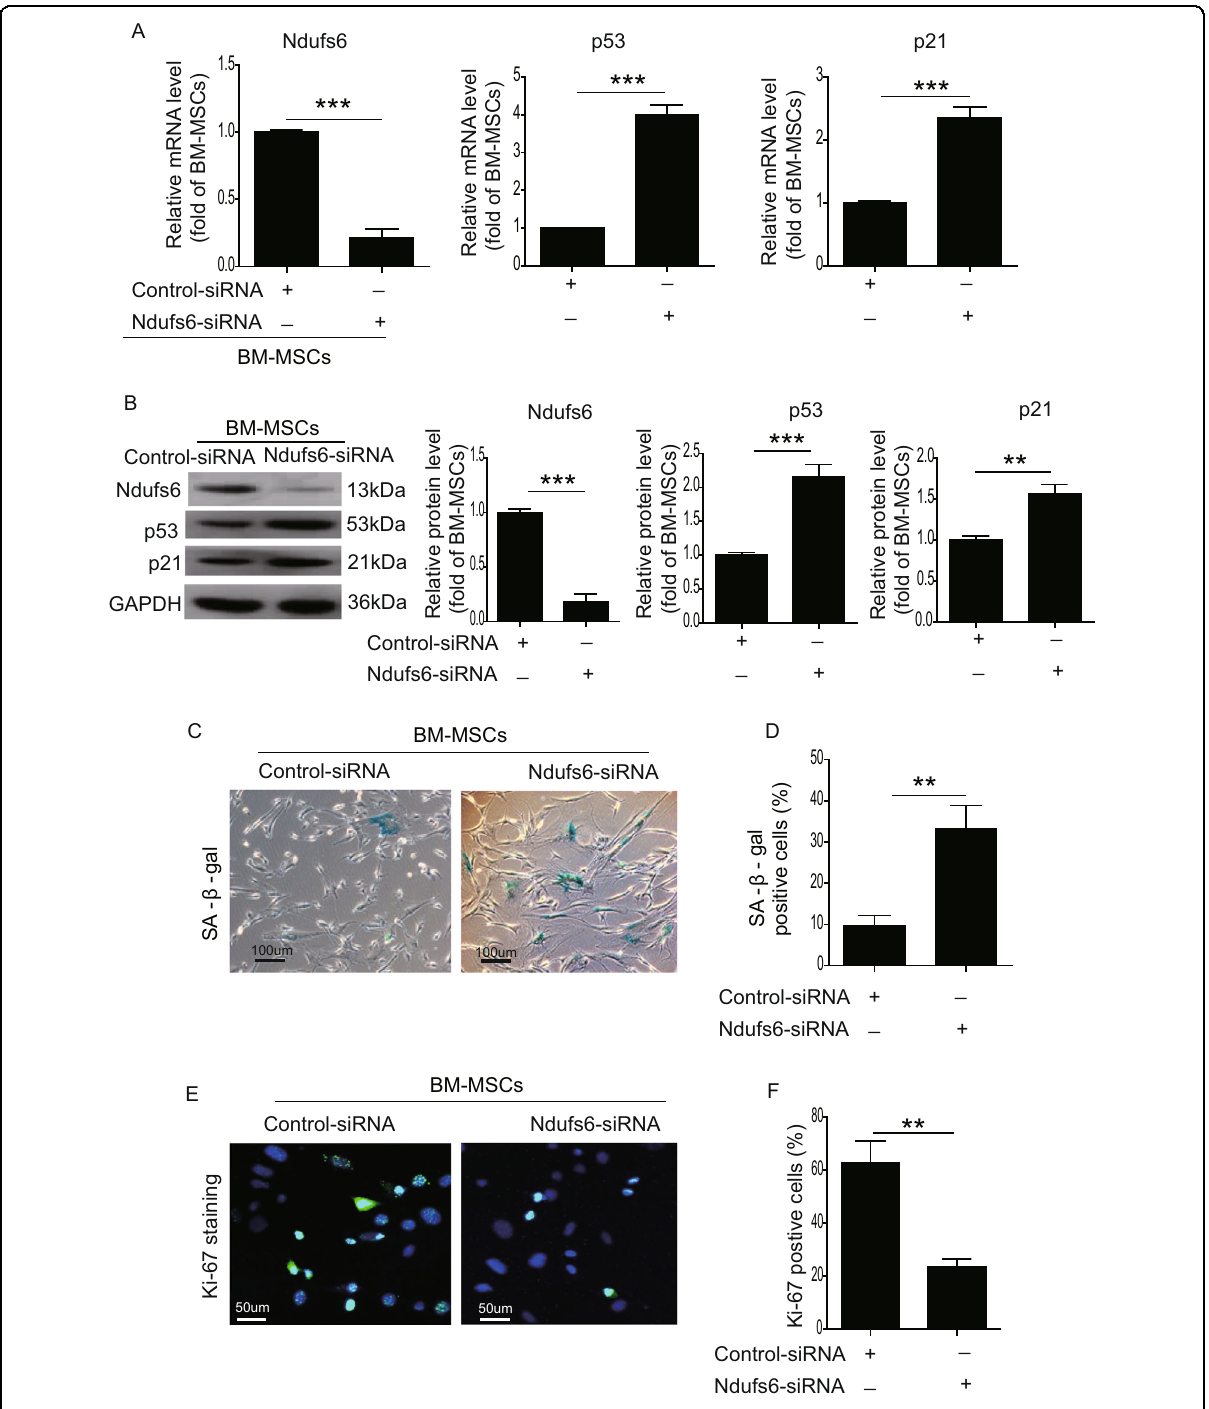
Fig. 3 Ndufs6 knockout accelerates cellular senescence in BM-MSCs. A The mRNA level of Ndufs6, p53, and p21 was detected in BM-MSCs and Ndufs6-siRNA-treated BM-MSCs. B The protein level of Ndufs6, p53, and p21 was detected in BM-MSCs and Ndufs6-siRNA-treated BM-MSCs. C SA- β -gal staining showing β -gal-positive cells in BM-MSCs and Ndufs6-siRNA-treated BM-MSCs. D The β -gal positivity in BM-MSCs and Ndufs6-siRNA- treated BM-MSCs was quanti fi ed by calculating the ratio of stained cells to total cells. E The proliferation of BM-MSCs and Ndufs6-siRNA-treated BM- MSCs was assessed by Ki-67 staining. F The Ki-67 positivity in BM-MSCs and Ndufs6-siRNA-treated BM-MSCs was quanti fi ed by calculating the ratio of stained cells to total cells. Results are presented as mean ± SD. n = 3. **p < 0.01; ***p <